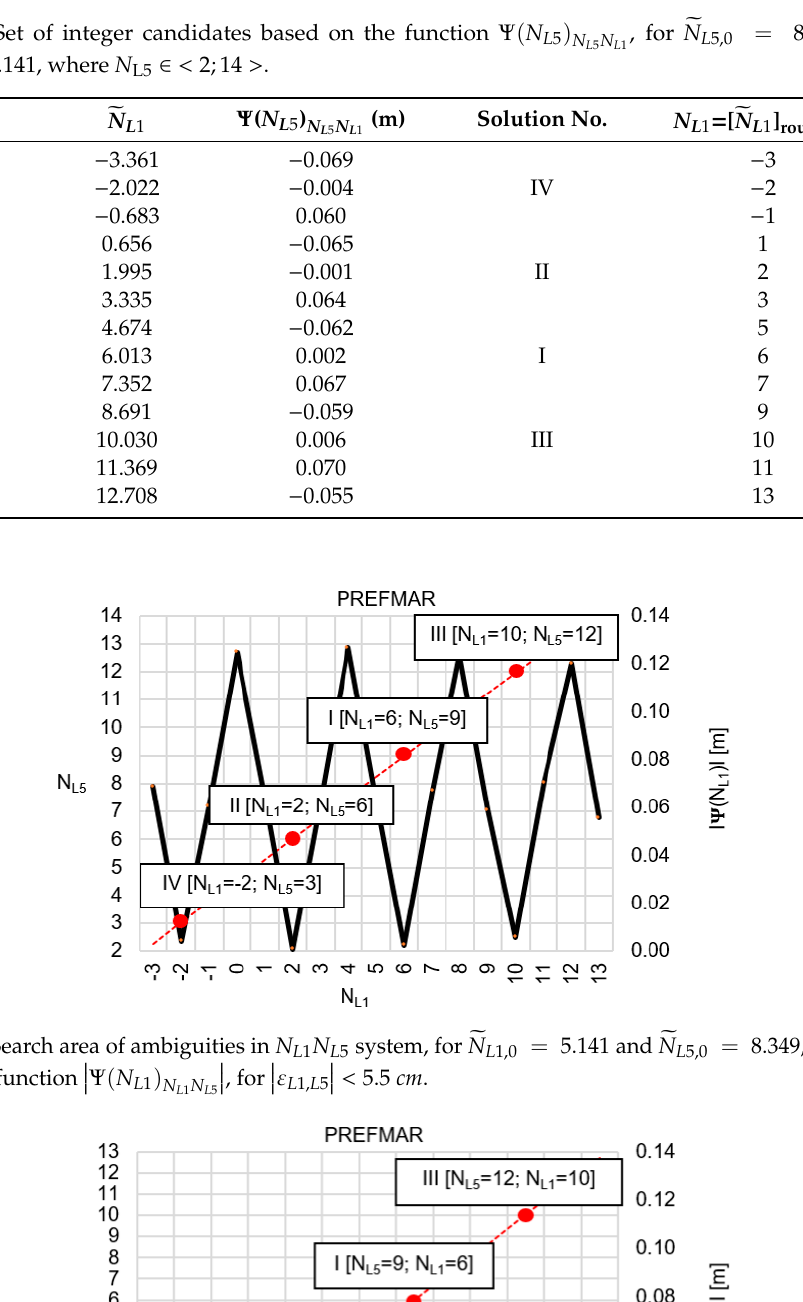
= 8.349 and (cid:101) N = 5.141, with L 5 N L 1 system, for (cid:101) N L 5,0 L 1,0